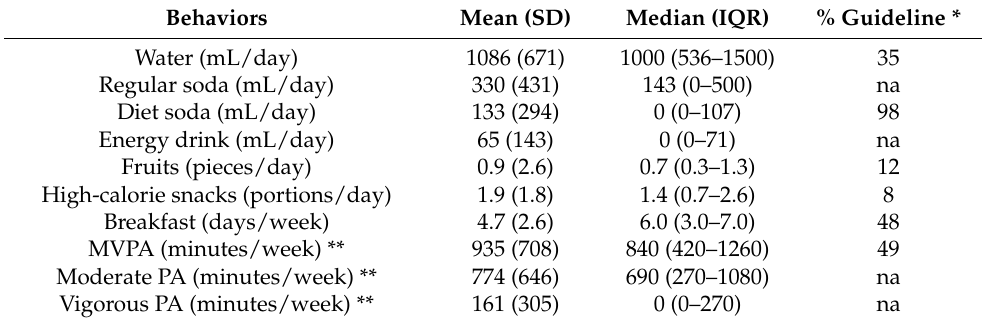
Table 2. Summary of means and standard deviations, median, and interquartile range for dietary and physical activity behaviors and percentage of the sample (N = 809) that met the